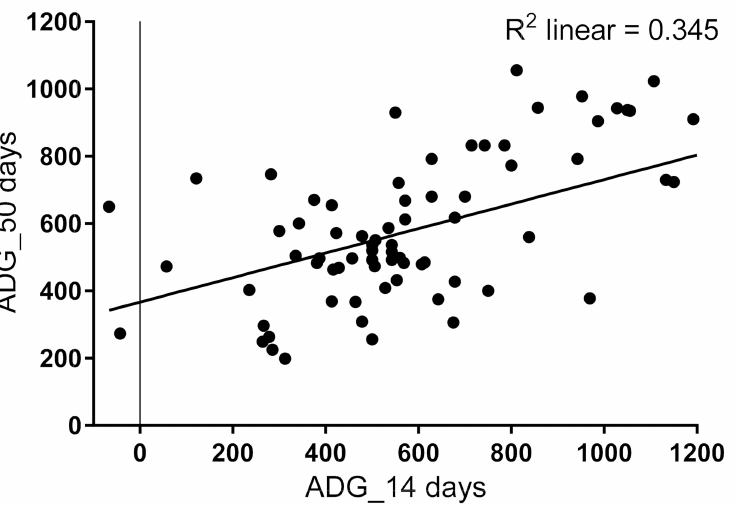
Figure 2. Average daily weight gain (ADG) of calves within the first 14 days compared with ADG within 50 days ( r = 0.588; p < 0.001; n =